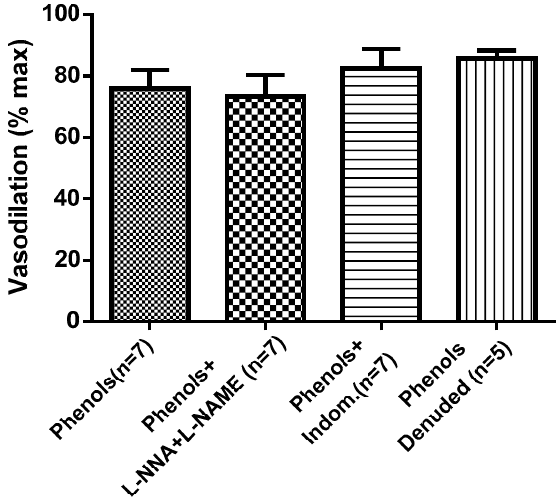
Figure 3. Extra virgin olive oil phenol-induced vasodilation is endothelium-independent. Phenols from crude extra virgin olive oil were tested at 3 × 10 − 5 M on isolated resistance mesenteric arteries in the absence (phenols) and presence of the nitric oxide synthase inhibitors N ω -Nitro- l -arginine methyl ester hydrochloride ( l -NAME) + N ω -Nitro- l -arginine ( l -NNA), each at 100 µ M, or of the cyclooxygenase inhibitor (Indom, 10 µ M). Further, phenols were also tested on the mesenteric artery without the endothelium (denuded). Data are reported as the mean ± SEM, n (experimental number). Further, EVOO phenols were also tested on MA in the presence of the guanilate cyclase inhibitor, ODQ, or in the presence of the adenilate cyclase inhibitor, SQ. Neither inhibition of cyclic adenosine monophosphate (cAMP) nor cyclic guanosine monophosphate (cGMP) production interfered with the vasodilation induced by EVOO phenols (Figure 4).